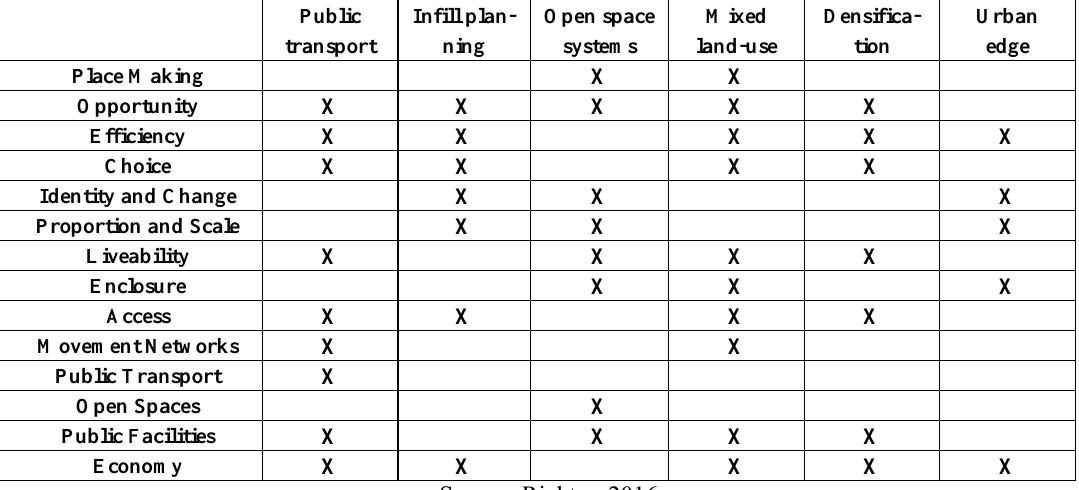
Table 5: Relationship between land use management tools and spatial planning